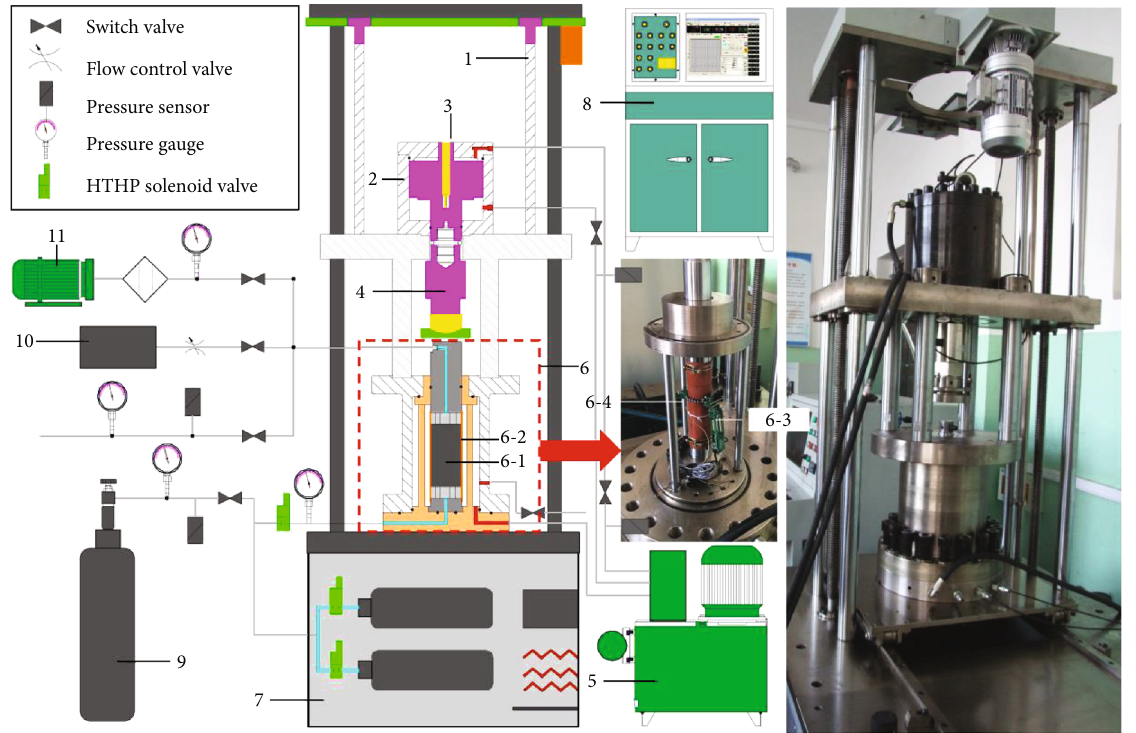
Figure 3: Schematic diagram of the testing apparatus. 1. Loading frame; 2. Axial loading hydro-cylinder; 3. Displacement sensor; 4. Stress sensor; 5. Servo hydraulic station; 6. Triaxial compression chamber; 6-1. Coal sample; 6-2. Heat shrinkable tube; 6-3. Circumferential extensometer; 6-4. Temperature sensor; 7. Constant-temperature oil bath; 8. Data acquisition system; 9. Gas cylinder; 10. Gas mass fl ow meter; 11. Vacuum pump;